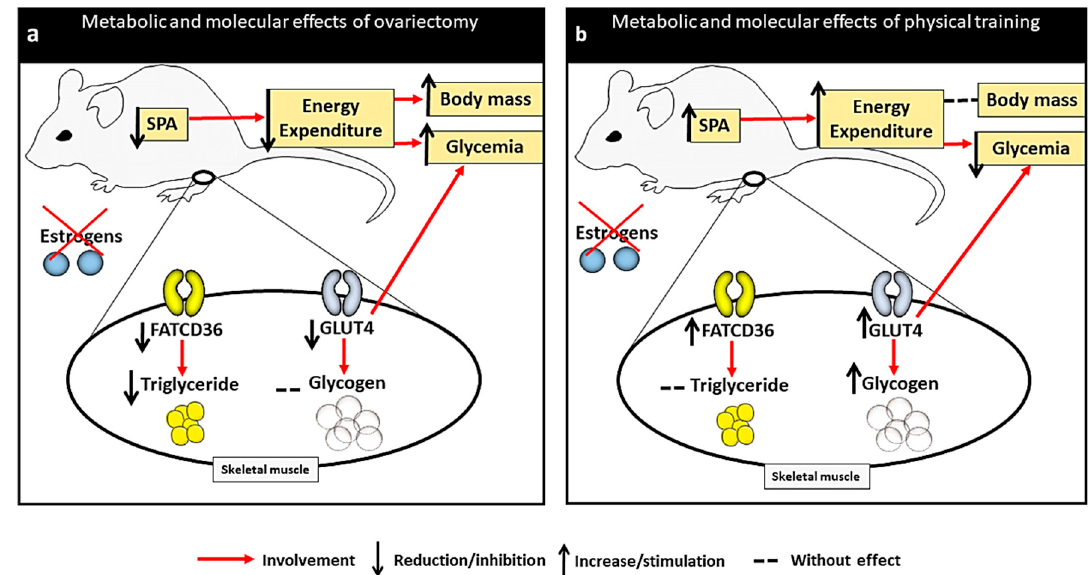
Figure 5. Illustration of the statistical effects (factorial ANOVA) of ovariectomy and physical training on metabolic and molecular parameters investigated in this study. ( a ) Representation of the ovariectomy effect causing reduction in the variables spontaneous physical activity, GLUT4 (soleus), FAT CD36 (soleus) and muscular triglyceride (gluteus maximus) with consequent increase in blood glucose and body mass. ( b ) Representation of the effect of physical training in ovariectomized rats preventing most of these metabolic impairments by increasing of the spontaneous physical activity, GLUT4 (soleus), FAT CD36 (soleus) and glycogen (soleus) with consequent reduction in blood glucose. SPA: spontaneous physical activity.